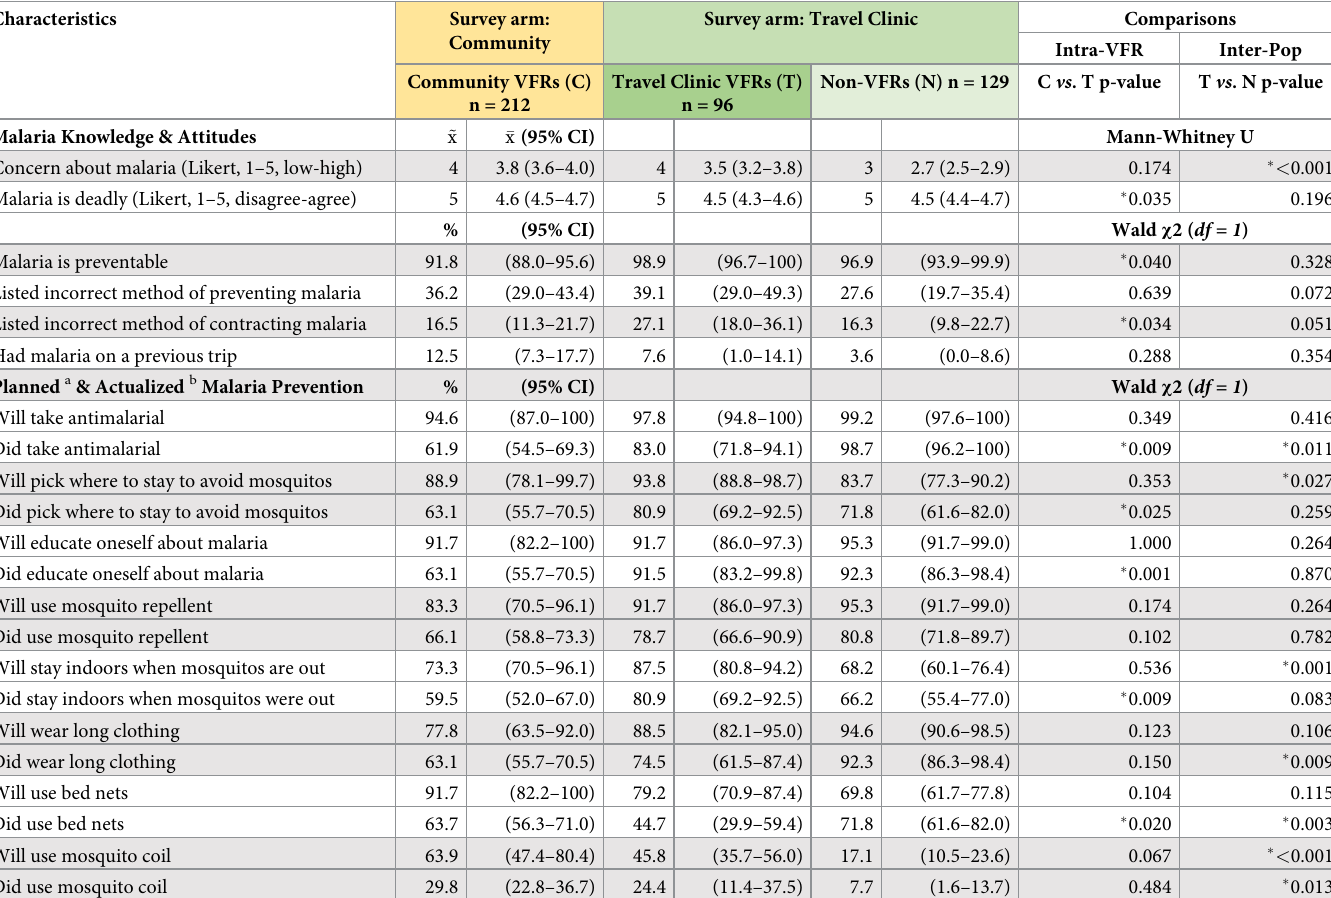
Table 3. A cross-sectional, multi-setting survey of malaria prevention knowledge, attitudes, and practices among US travelers to sub-Saharan Africa: Inter- and intra-population differences among travelers visiting friends and relatives (VFRs) and other types of travelers to similar destinations (non-VFRs), by survey arm and traveler